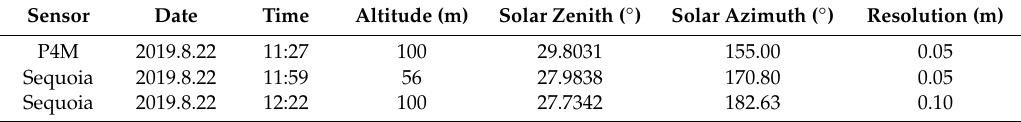
Table 2. Parameters of sensors used for comparison. During the data collection process, the P4M camera failed to successfully acquire image data with a resolution of 10 cm. The 10 cm image data used in the comparative experiment was obtained by resampling the 5 cm